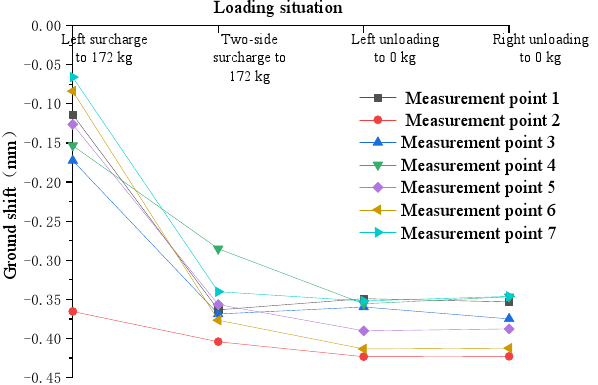
Left surcharge to 172 kg